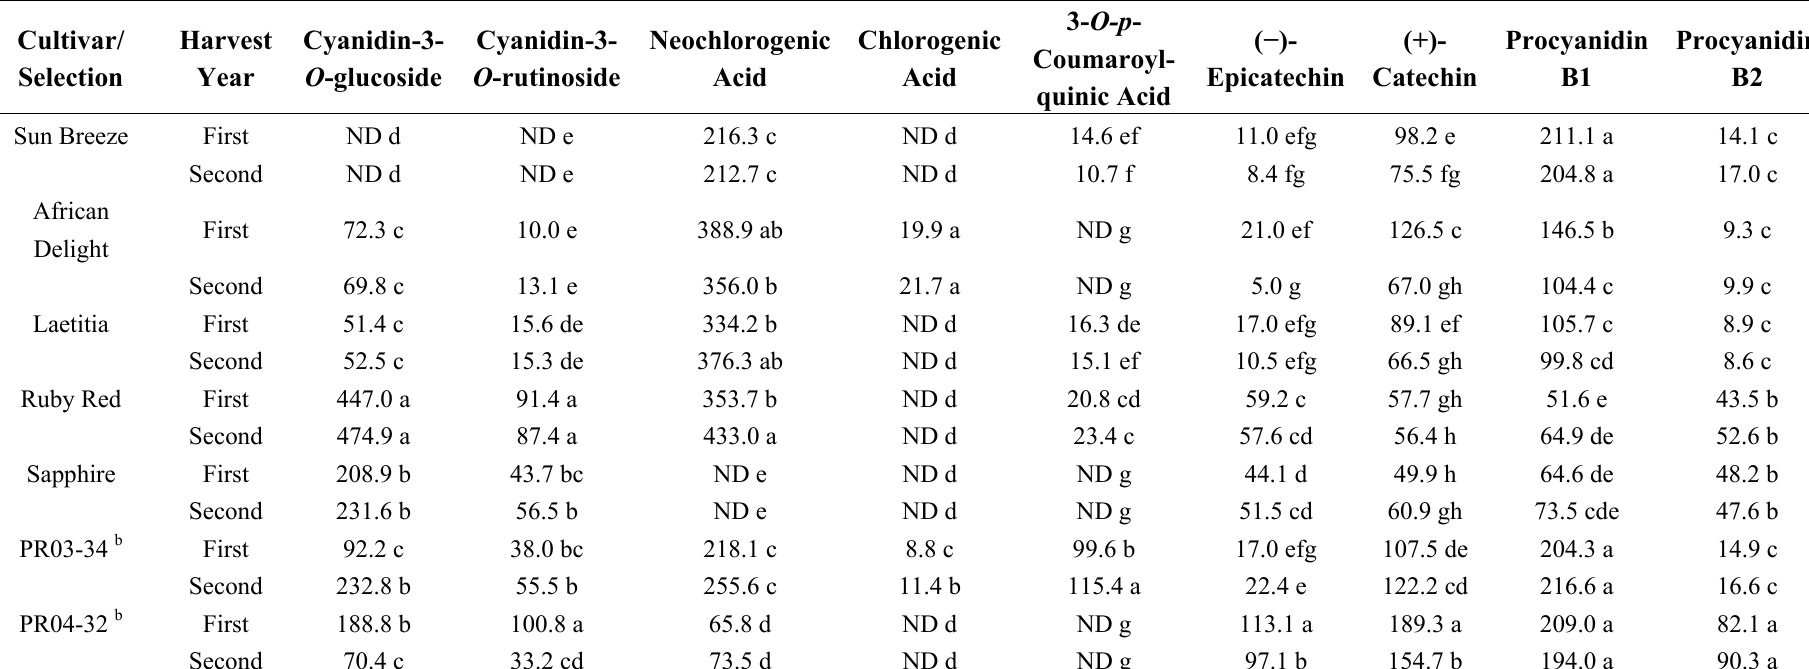
Table 8. Individual phenolic compound content (mg/kg fresh weight) a for ripe fruits from South African plum ( Prunus salicina Lindl.) cultivars and selections harvested during two consecutive harvest seasons b